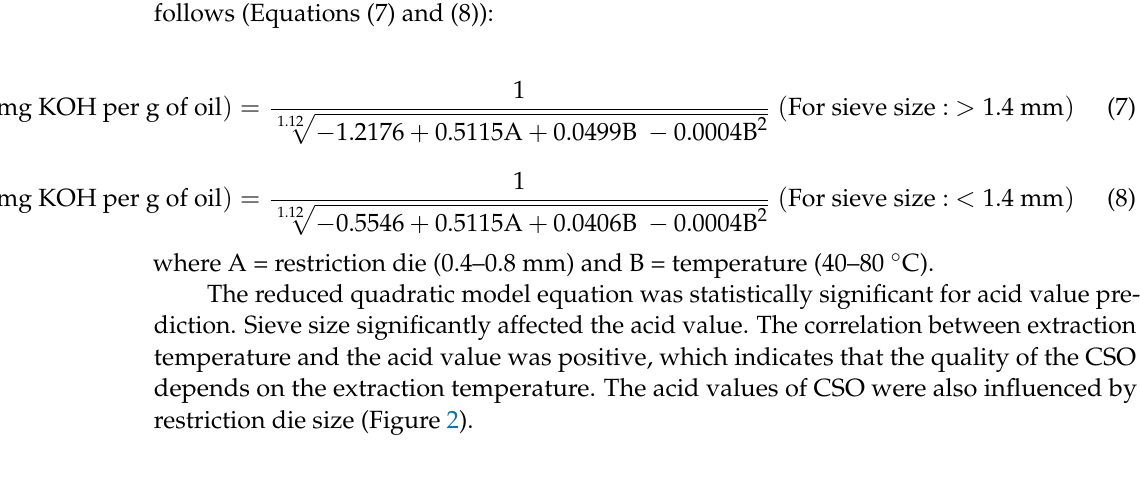
The predicted acid value of the CSO of the center point (restriction die: 0.6 cm, temperature: 60 ◦ C, and sieve size > 1.4 mm) STDs 9, 10, and 11 was 1.54 mg KOH/g of oil, whereas the actual acid values of the oil samples were 1.79, 1.33, and 1.69 mg KOH/g of oil, respectively. Another predicted acid value of the center point (restriction die: 0.6 cm, temperature: 60 ◦ C, and sieve size < 1.4 mm) STDs 20, 21, and 22 was 1.34 mg KOH/g of oil, but the actual acid values were 1.46, 1.07, and 1.41 mg KOH/g of oil, respectively (Table 2). The lowest acid value was observed in STD 21 (restriction die: 0.6 cm, temperature: 60 ◦ C, and sieve size < 1.4 mm), with an actual value of 1.07 mg KOH/g of oil compared with the predicted value of 1.34 mg KOH/g of oil (Table 2). An analysis of the variance of the reduced quadratic model for the acid value was carried out. The reduced quadratic model for acid value was significant ( p = 0.0008) with adjusted R 2 (0.6601), predicted R 2 (0.5050), and non-significant lack of fit ( p = 0.9395) values. The results indicated that the reduced quadratic model equation was used for predicting the acid values of the CSO